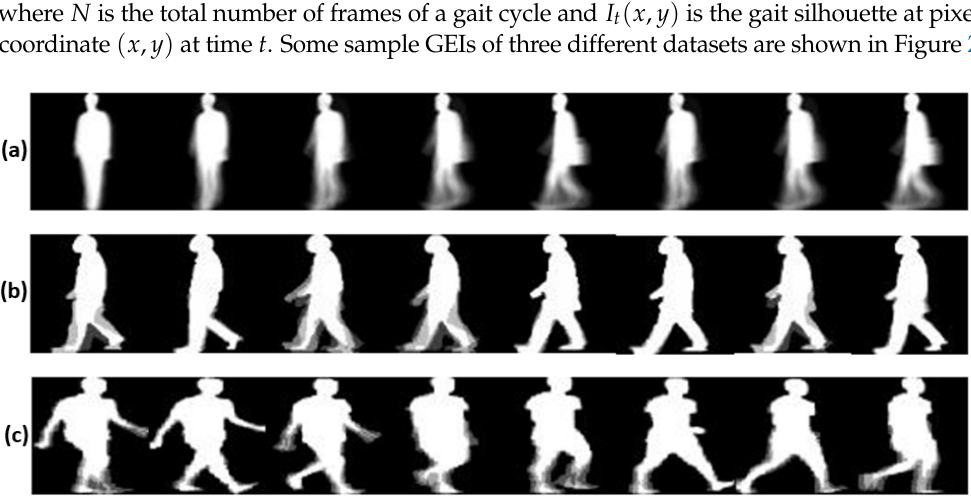
Figure 2. Sample GEIs from ( a ) CASIA-B dataset, ( b ) OU-ISIR D dataset, and ( c ) OU-LP